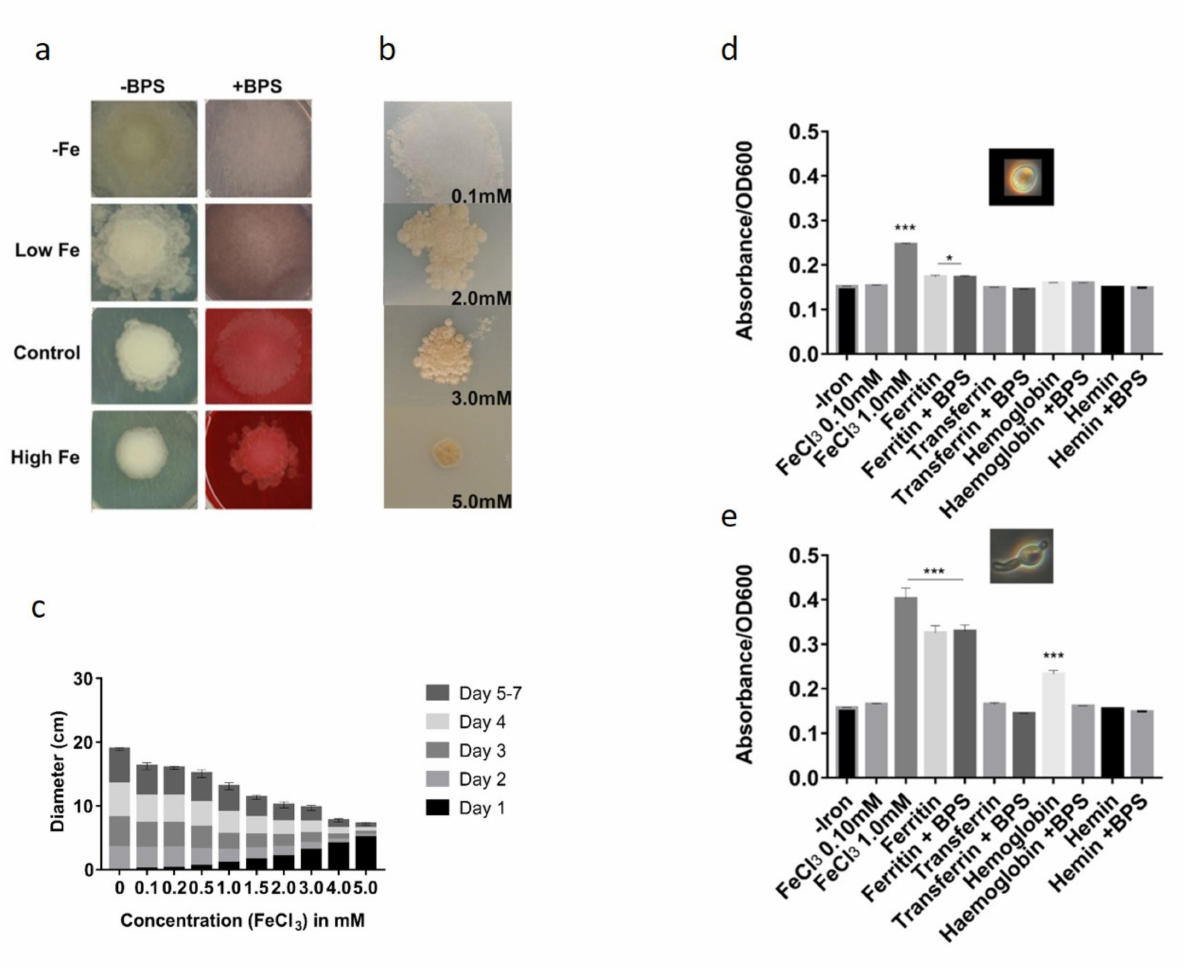
Figure 4. L. corymbifera growth under iron stress. ( a ) L. corymbifera cultures were harvested after seven days of growth on SC medium supplemented with 0.10 mM FeCl 3 , washed and 10 4 spores were spotted on SC medium supplemented or not with 0.2 mM BPS and 0.1 mM, 0.2 mM and 1.0 mM FeCl 3 . ( b ) Phenotypic comparison of the L. corymbifera growth under iron stress conditions. Growth on SC medium supplemented with 0.1, 2.0, 3.0, and 5.0 mM FeCl 3 . ( c ) Mycelial growth on increasing concentrations of iron for 7 days. Diameter measurements were taken from triplicate plates. Error bars indicate the standard error at day 7. ( d ) Germination of L. corymbifera spores in different iron sources: spores were inoculated into liquid SC medium supplemented or not with 0.2 mM BPS and ferritin, transferrin, hemoglobin and hemin (100 µ g/ mL) independently. * p < 0.05, *** p <